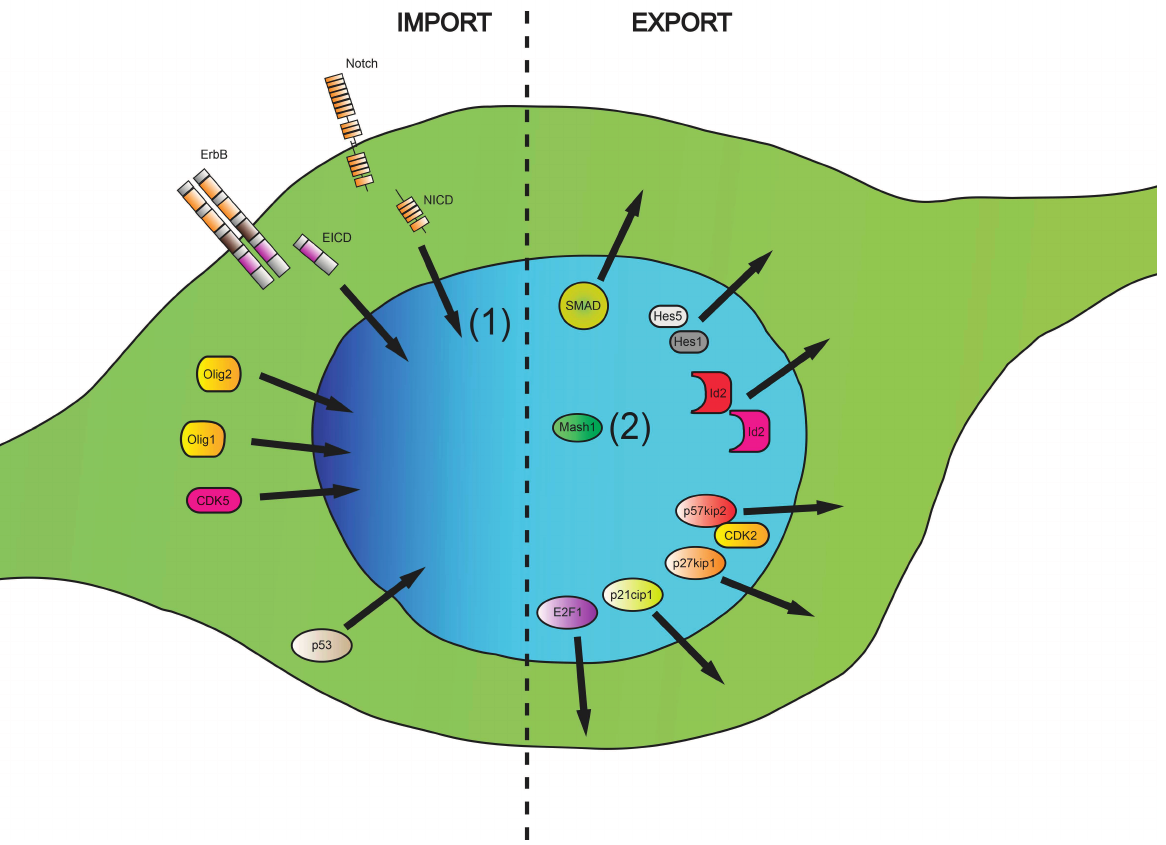
Figure 3. Summary of intracellular translocation directions of selected key proteins involved in transcriptional regulation, cell cycle control and transmission of cell surface signals revealed to be important for differentiation of immature oligodendroglial